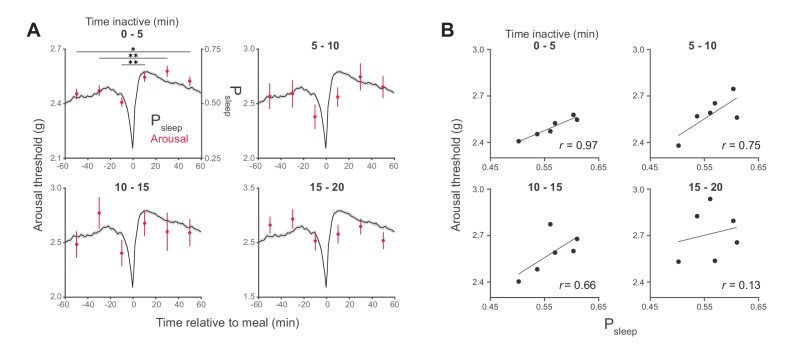
Arousal threshold surrounding meals with increasing sleep duration state.(A) Stimulus response from 0–20, 20–40, and 40–60 min pre- and post-meal (red) superimposed onto Psleep (black) representing the entire data set. Arousal events are filtered to 5-min intervals for prior time inactive (0–5 min duplicated from Figure 2) to control for sleep depth. (B) Correlation between Psleep and arousal threshold for 0–20, 20–40, and 40–60 min bins surrounding feeding events (Pearson correlation, six time-bins derived from 2245 meals from 180 flies, Canton-S).